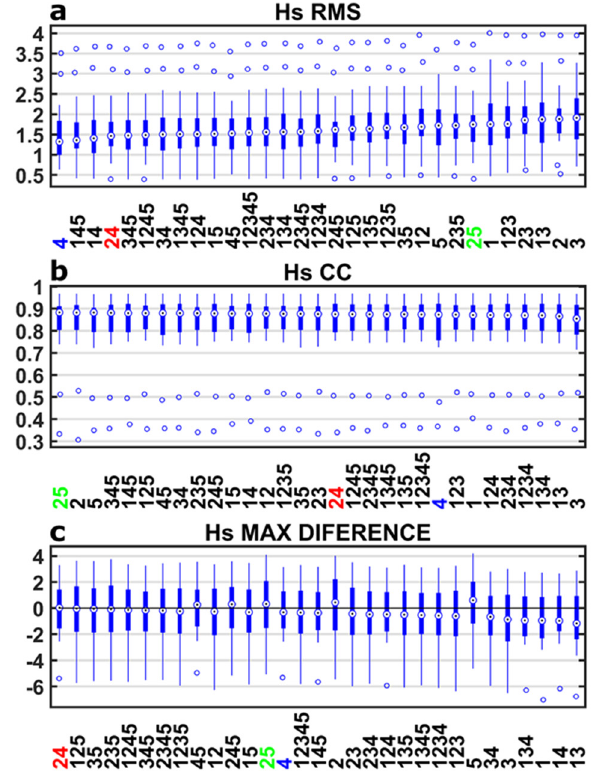
Figure 11. Significant wave height: ( a ) root-mean-square error; ( b ) correlation coefficient; and ( c ) difference between maximum simulated and measured. The numbers in the x -axis indicate the models included in each permutation: (1) EM04; (2) EM11; (3) HL80; (4) RK; and (5) SLOSH. The error measures are calculated from the time series selected by 24 h before and after the TC crosses the buoys. Each box represents the 25th percentile (bottom) and 75th percentile (top), the median is the blue circle with a black point inside, the blue lines represent the 10th percentile (bottom) and 90th percentile (top), blue circles points represent above and below 90th percentile and 10th percentile. The error measures are ordered from less to more error denoting the results in blue RMS, green for CC, and red for the maximum difference.